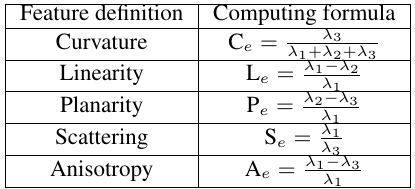
Table 1. Computing method for eigen value-based shape features. Feature definitions on the left refer to explanation above. Three eigen value symbols are sorted in descending order from 1 to 3 in the